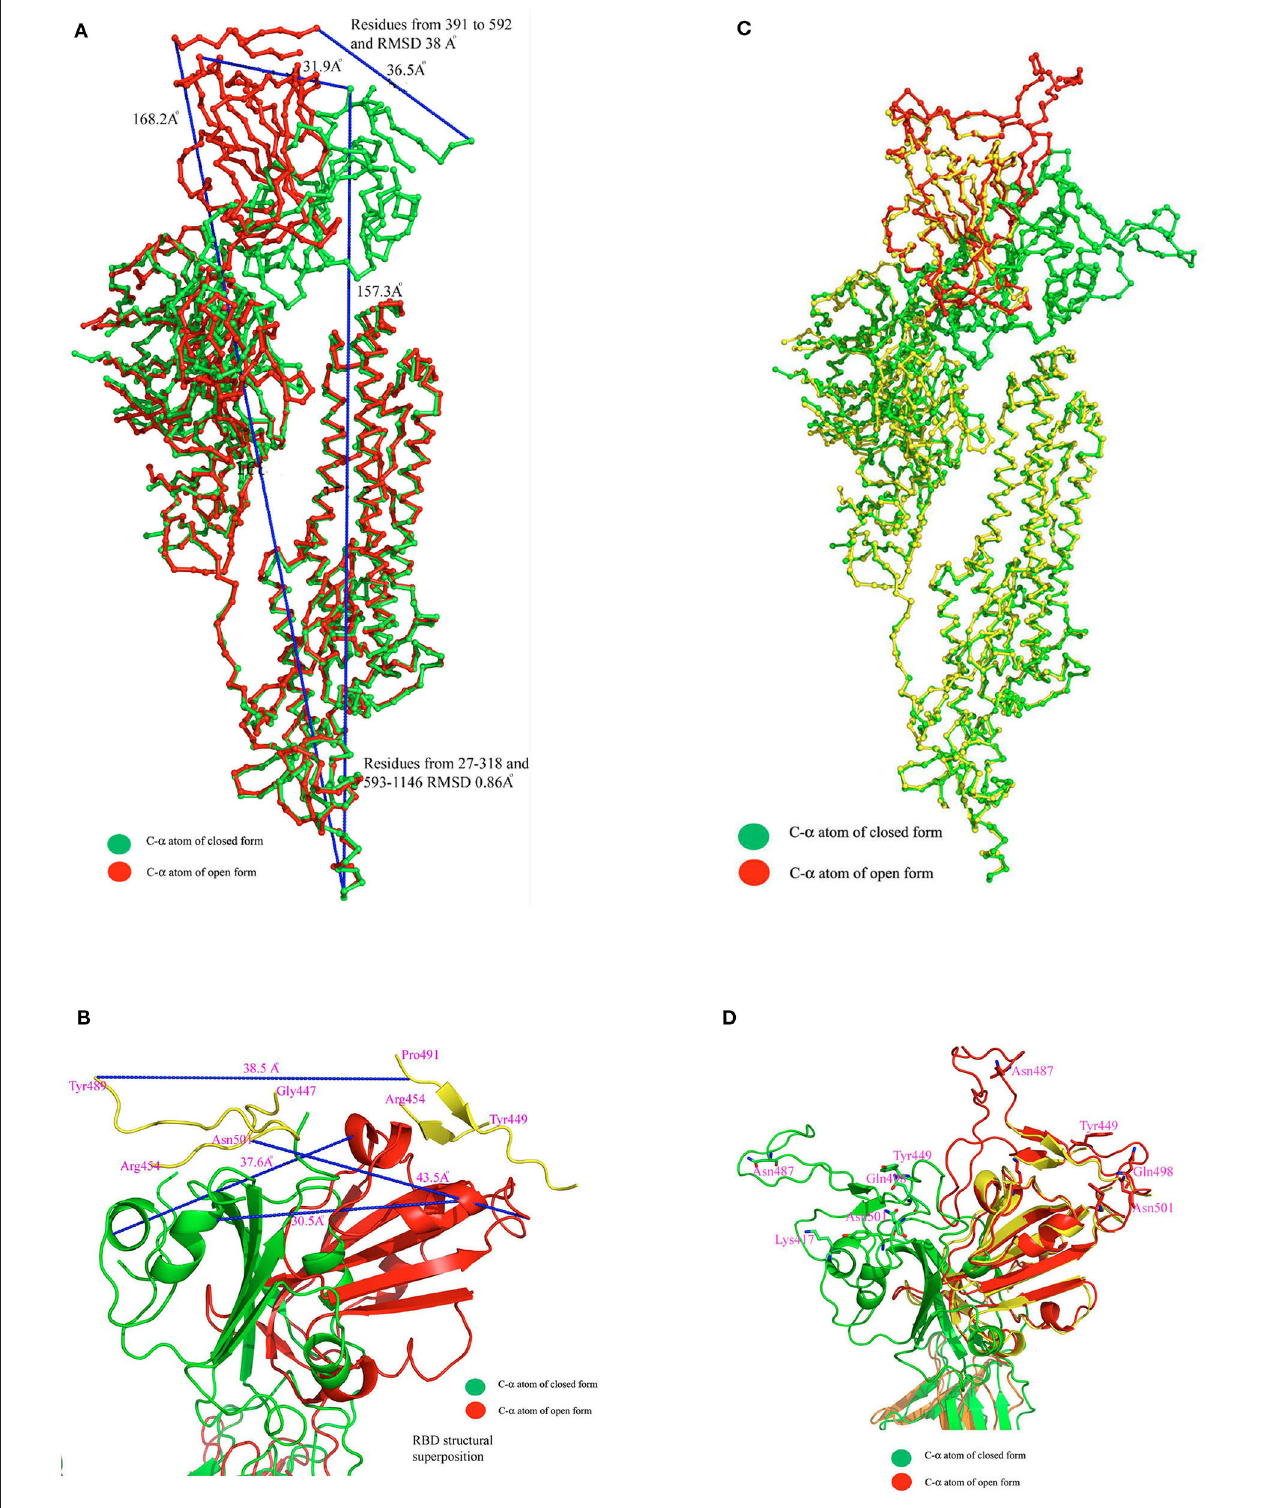
FIGURE 1 | (A) C- α atom superposition of 6vsb with 6vxx coordinates. This alignment shows C- α atoms from residues 27–318 and 563–1146 aligns on top of each other with root mean square deviation (rmsd) 0.86 Å. (B) Magnified cartoon diagram that shows only RBD of both structures with superposition and RMSD